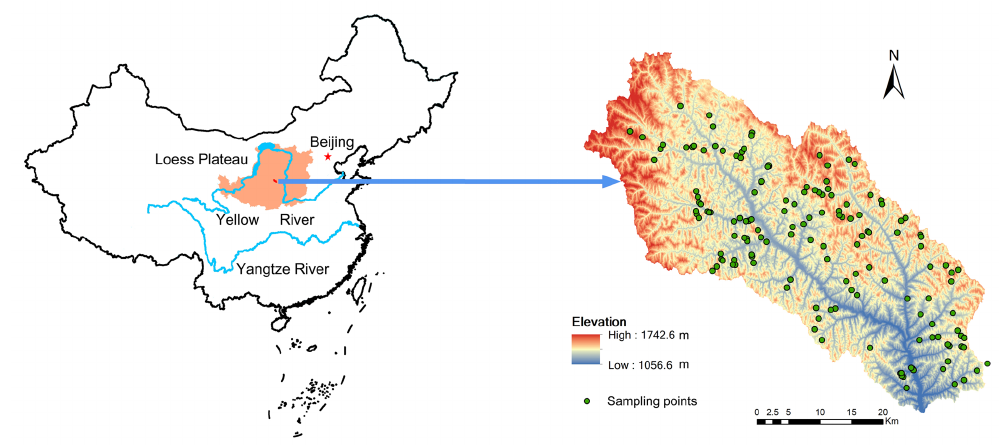
Figure 1. Locations of the study area and the sampling points. Table 1. Landscape and soil characteristics in the study